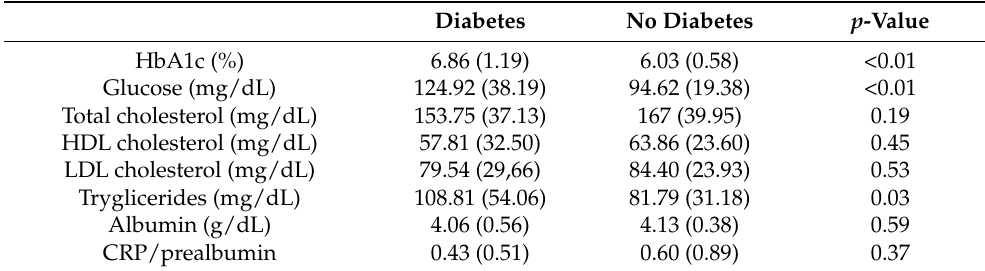
Table 4. Difference in metabolic parameters depending on the presence of diabetes mellitus (DIA- BETES) or alterations in carbohydrates metabolism (NO